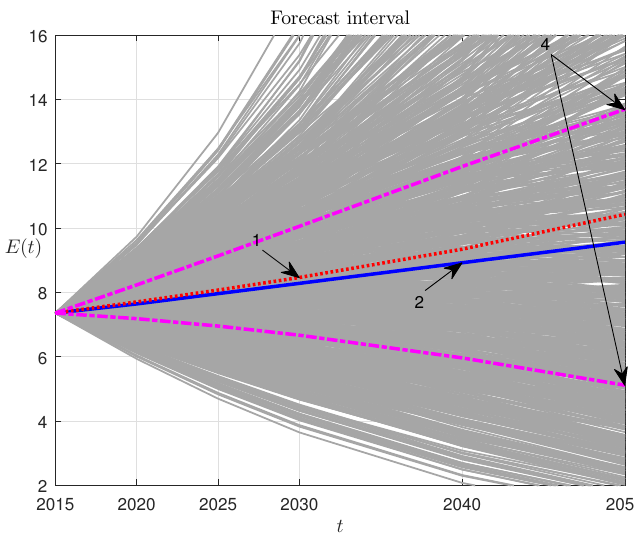
Figure 5. The ensemble of projection trajectories on the prediction interval.